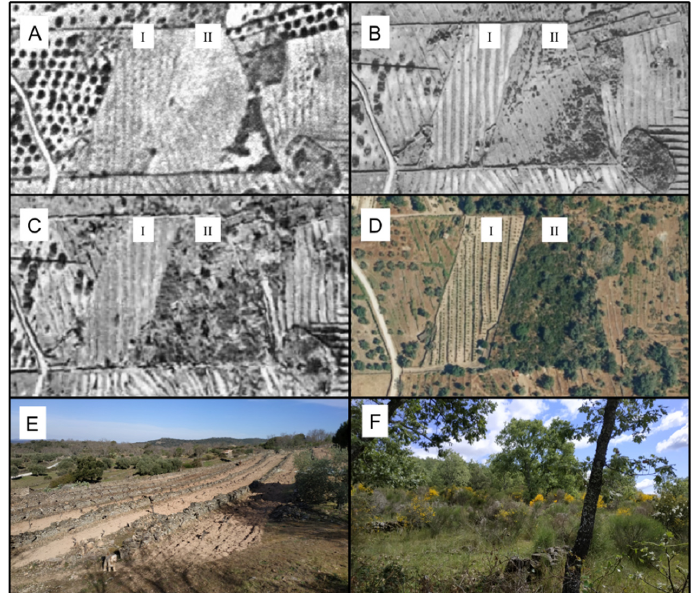
Figure 2. As an example, evolution of the soils of the two sampling points; I: location considered permanent cultivated soil (CS); II: location considered abandoned agricultural soil (AS). ( A ) Aerial picture (1956). ( B ) Interministry orthophoto (1976). ( C ) Orthophoto SIG Oleícola (1998). ( D ) Satellite image SIGPAC (2016). ( E ) Current picture of point 1.I (2020). ( F ) Current picture of point 1.II (2020). (Source: images gathered from IDEE and own source).